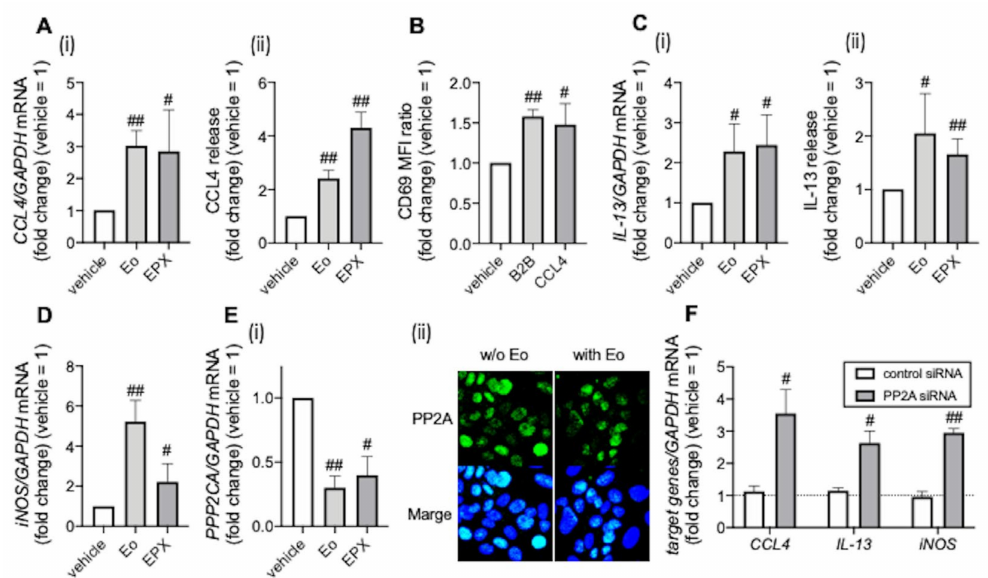
Figure 2. Association between clinical markers of eosinophilic airway inflammation and PP2A. ( A , C – E ) BEAS-2B cells were co-incubated with purified peripheral blood eosinophils overnight or recombinant eosinophil peroxidase (EPX, 10 µ g/mL; Proteintech, Rosemont, IL, USA) for 72 h. CCL4 ( A ) and IL-13 expression levels ( C ) ((i) mRNA levels, (ii) protein levels in culture supernatants), iNOS mRNA levels ( D ), and PP2A expression ( E ) ((i) mRNA levels, (ii) protein levels) were evaluated. ( B ) Purified peripheral blood eosinophils were incubated with BEAS-2B cells or CCL4 (10 µ g/mL; Abcam, Cambridge, UK) overnight. CD69 expression on eosinophils was evaluated. ( F ) mRNA levels of CCL4, IL-13, and iNOS in BEAS-2B cells treated with siRNA were evaluated. Values in panels represent the means ± SEM values of four ( A – E ) or three experiments ( F ); # p < 0.05, ## p < 0.01 (vs. vehicle or control siRNA). (ii) Images were obtained using a Carl Zeiss LSM700 confocal microscope (400 × objective). Results are representative of at least four